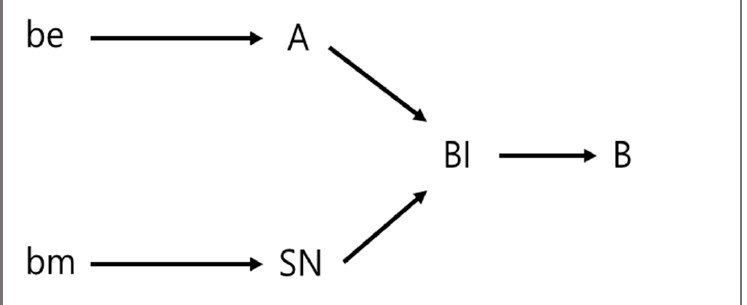
Figure 1. Fishbein/Ajzen model. B = behavior ; BI = behavioral intention ; A = attitude ; SN = subjective norms ; be = beliefs about the specific consequences of behavior multiplied by the evaluation ; bm = beliefs about the social expectations of specific others multiplied by the motivation to conform to them.